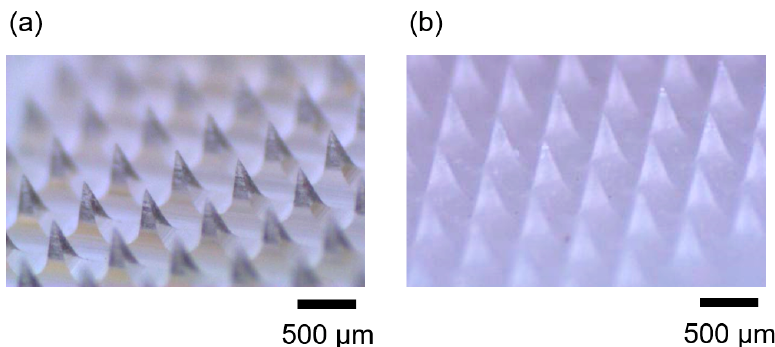
Figure 7. Photographs of the PLLA microneedle arrays fabricated using micromolding processes with different thermal histories. ( a ) PLLA microneedle array formed during micromolding with a rapid cooling process (>200 °C/min) from the molten state; crystallization time t = 0 min. The crystallinity was evaluated as 0.1%. ( b ) PLLA microneedle array formed in the micromolding process with crystallization from the molten state; crystallization time t = 20 min. The crystallinity was evaluated as 53.9%.